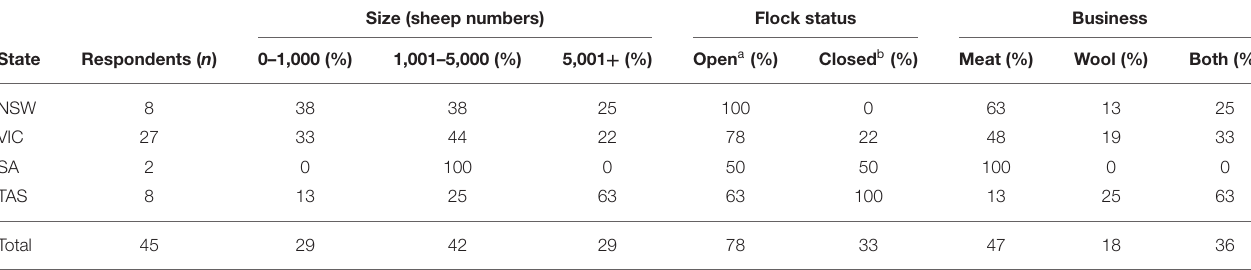
TABLE 1 | The property details, including size and business type, of respondents split by